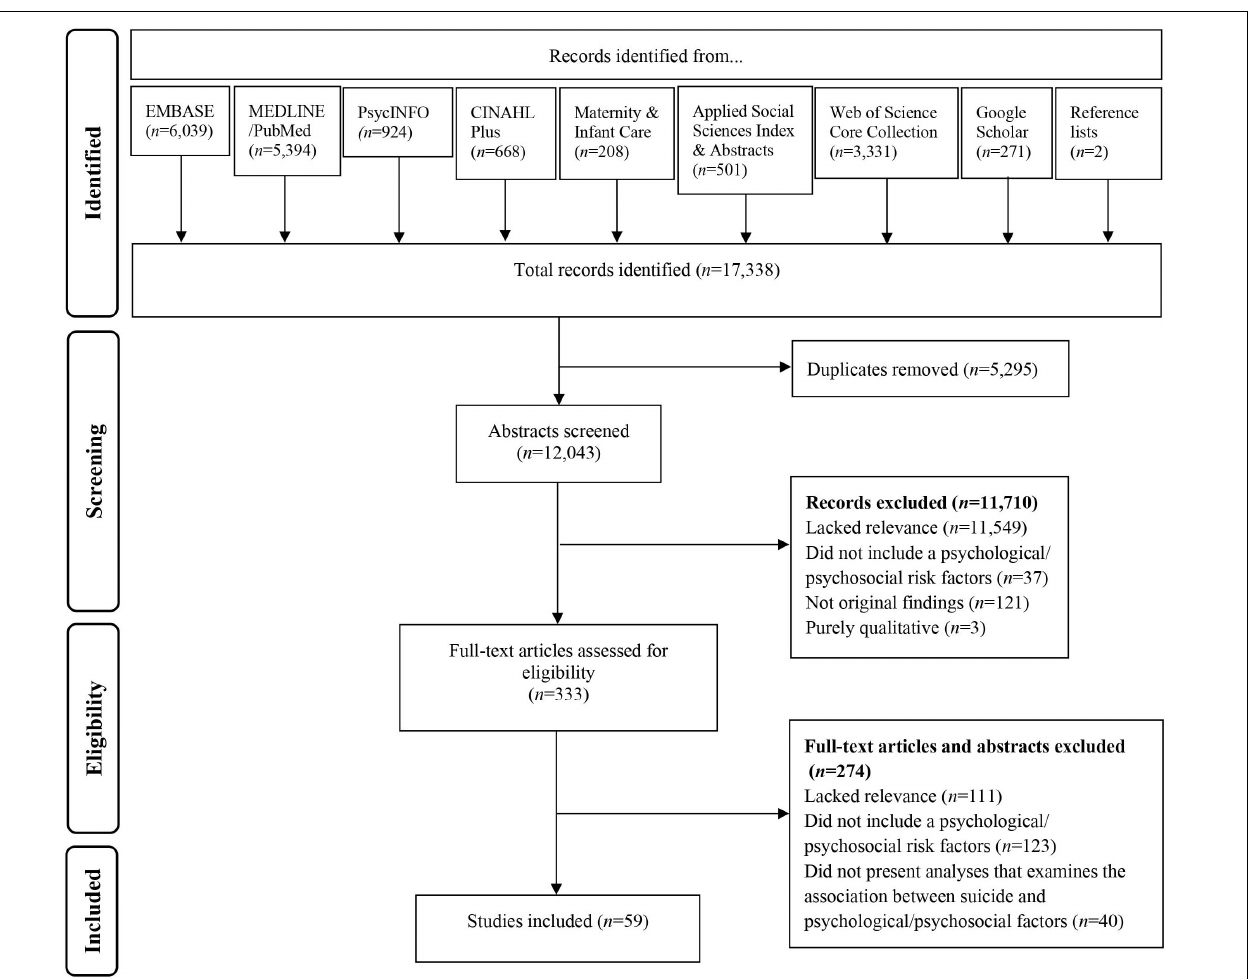
FIGURE 1 | Flowchart of paper selection based on PRISMA